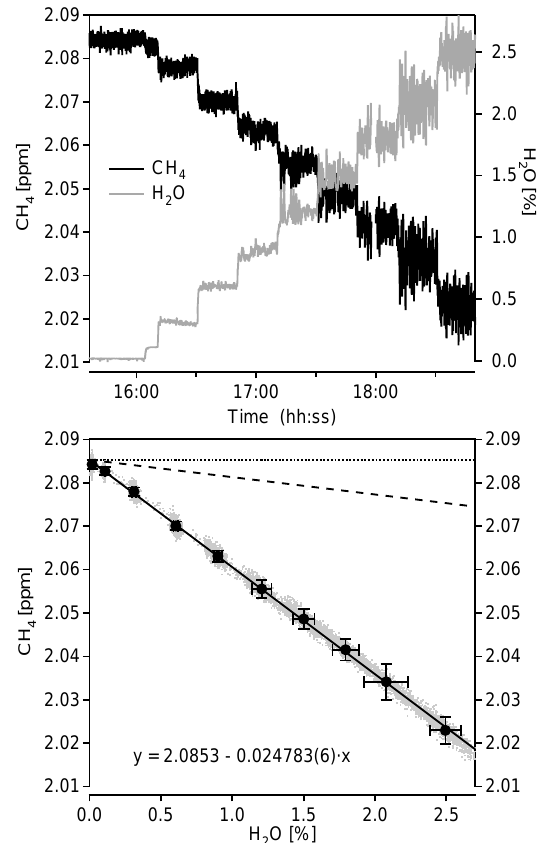
Fig. 3. Instrumental response to varying water vapor content. Top graph shows the methane mixing ratio changes measured by QCLAS over time induced by the stepwise addition of water vapour. The same behaviour was observed for both analyzers. The linear dependence of the CH 4 mixing ratio on the water vapour concen- tration as measured by QCLAS is indicated on the bottom graph. The gray dots show the original one-second data while the circles represent 20min averages (with 1 σ error bars) for the individual di- lution steps. The solid line is a linear fit through the averaged data points. The dashed line indicates the apparent CH 4 mixing ratio af- ter correction of the volumetric dilution (Eq. 3) by water vapor. The real (dry air) mixing ratio (dotted line) can only be obtained when an additional correction factor (Eq. 5) is applied to account for the pressure broadening